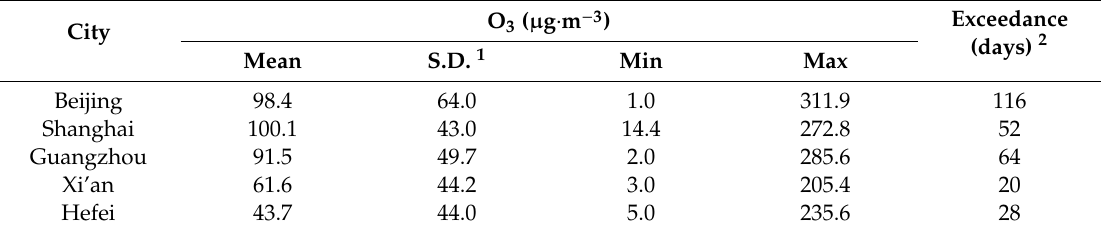
Table 1. The MDA8 O 3 concentrations in five provincial capital cities during 2014–2015.